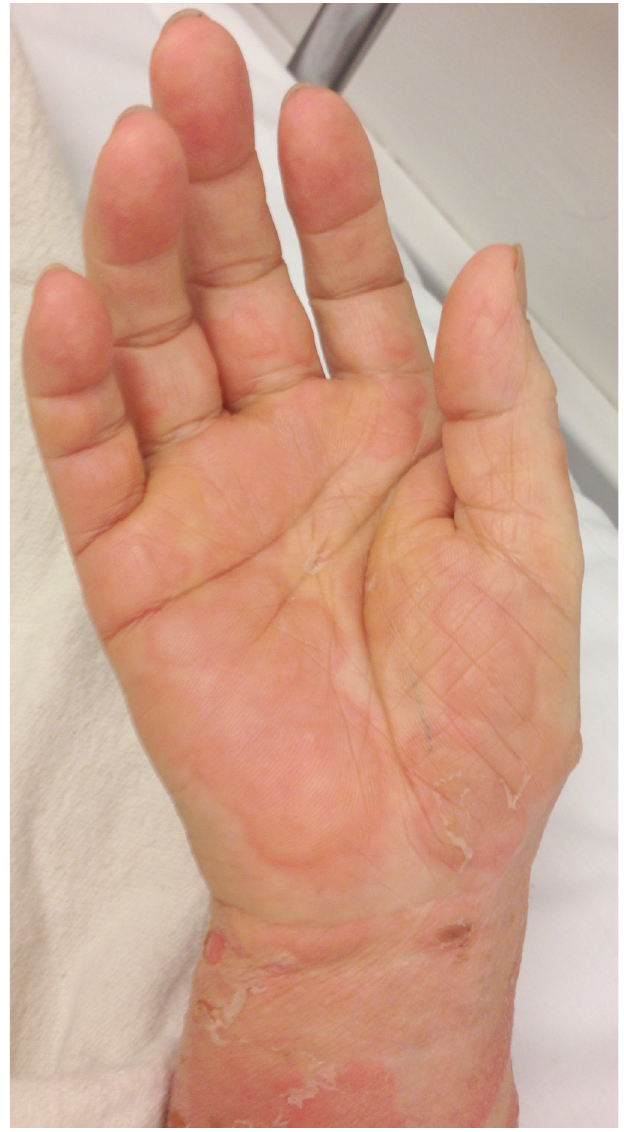
Figure 1. Skin findings include tense bullae on erythematous bases, pruritic plaques on the hands, and